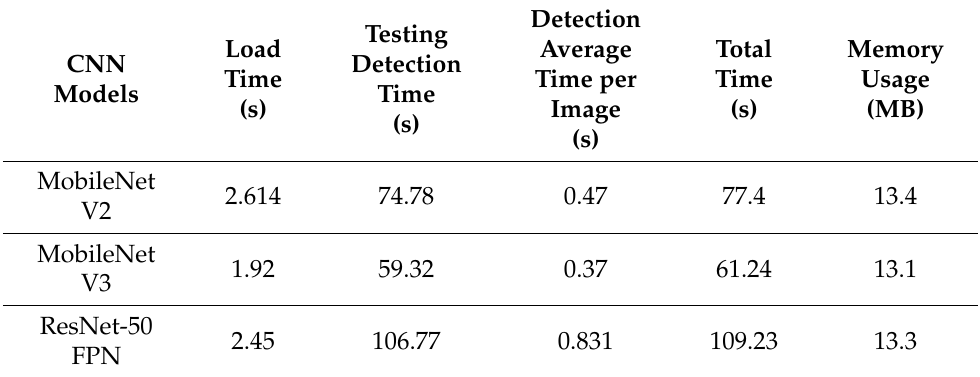
Table 4. Experimental Scenario I; cloud server version II (24-core system) detection time and memory